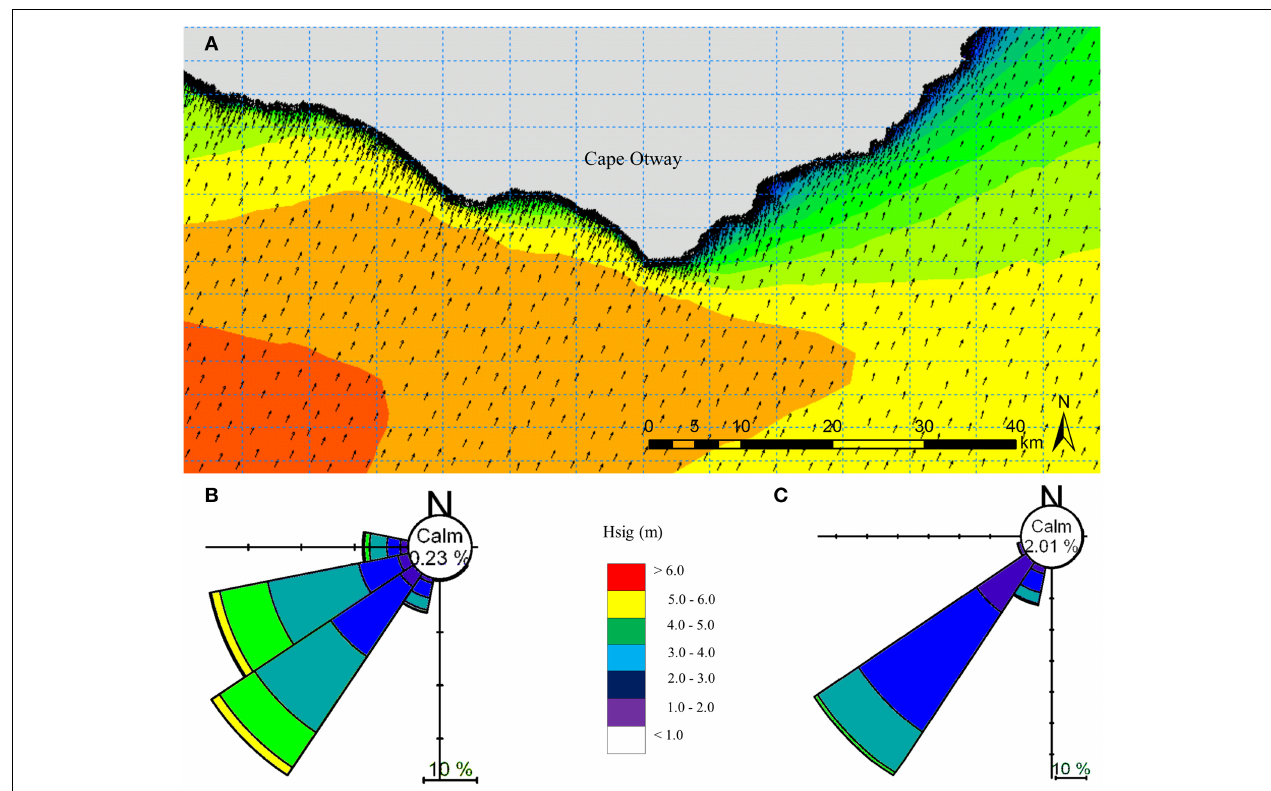
FIGURE 4 | Local scale spectral wave model hindcast for the year 2000 for the Cape Otway coast, Victoria, Australia (A). Depth attenuation information was provided using MBES (5m) and LiDAR (5m) bathymetry, while boundary conditions were obtained from the regional